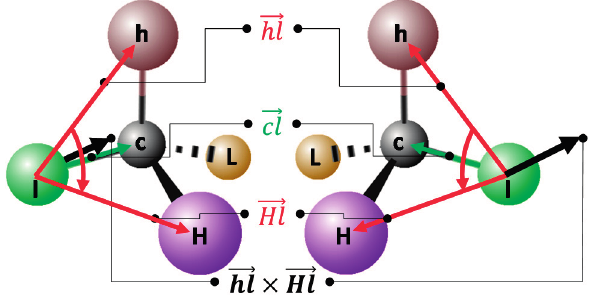
Figure 3. Calculation of the chirality index used to preserve the configuration of asymmetric